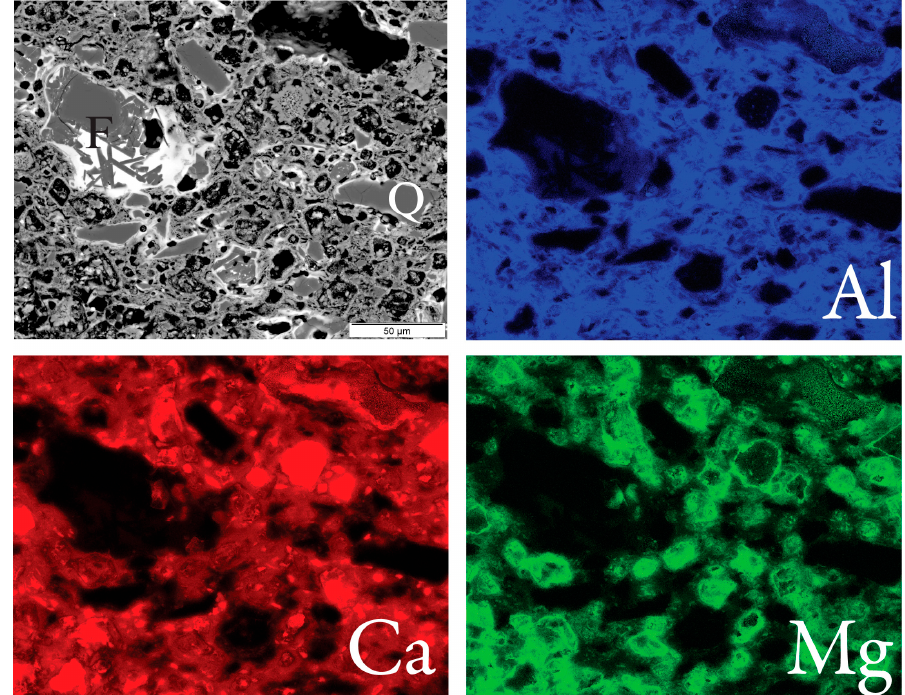
Figure 19. SEM-BSE image of a CaO-&MgO-rich white earthenware from the Robillard & C ie manufactory in Nyon, 1818–1832/33 [25] (An. no. BER 9) showing angular fragments of crushed quartz (Q) and angular to subrounded fragments of coarser PbO-SiO 2 -frits (F), as well as the corresponding elemental maps of Al, Ca, and Mg.